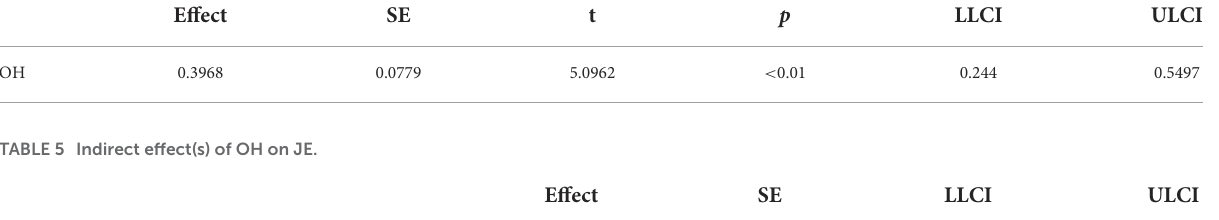
TABLE 4 Direct effect of OH on JE.